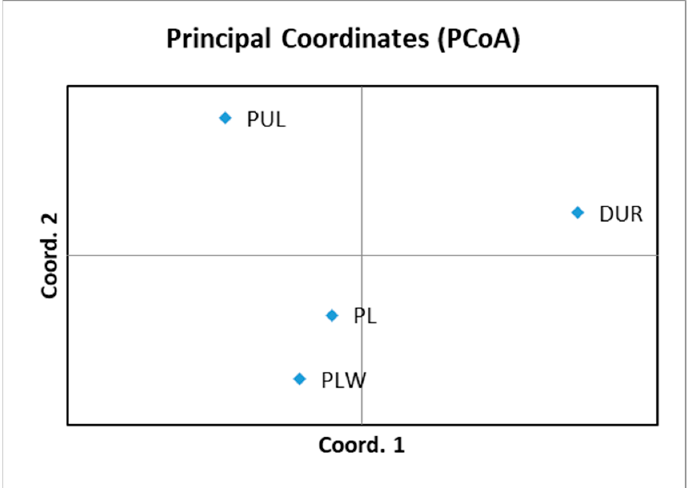
Figure 4. Principal coordinate analysis (PCoA) of the four pig breeds. DUR—Duroc; PUL—Pu ł aw- ska Pig; PL—Polish Landrace; PLW—Polish Large White. A two dimensional plot of the PCoA anal- ysis show the clustering of four breeds. The first and second coordinates account for 56.9% and 24.5%, respectively, of the total variation. respectively, of the total